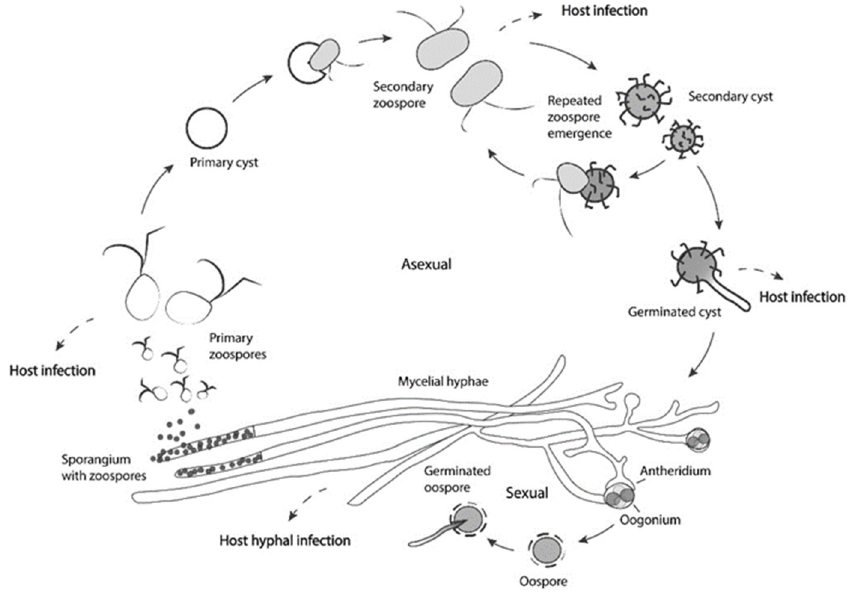
Figure 3. Scheme illustrating the sexual and asexual lifecycles of Saprolegnia spp. with the identification of the development stages able to cause infection in amphibians (host infection).